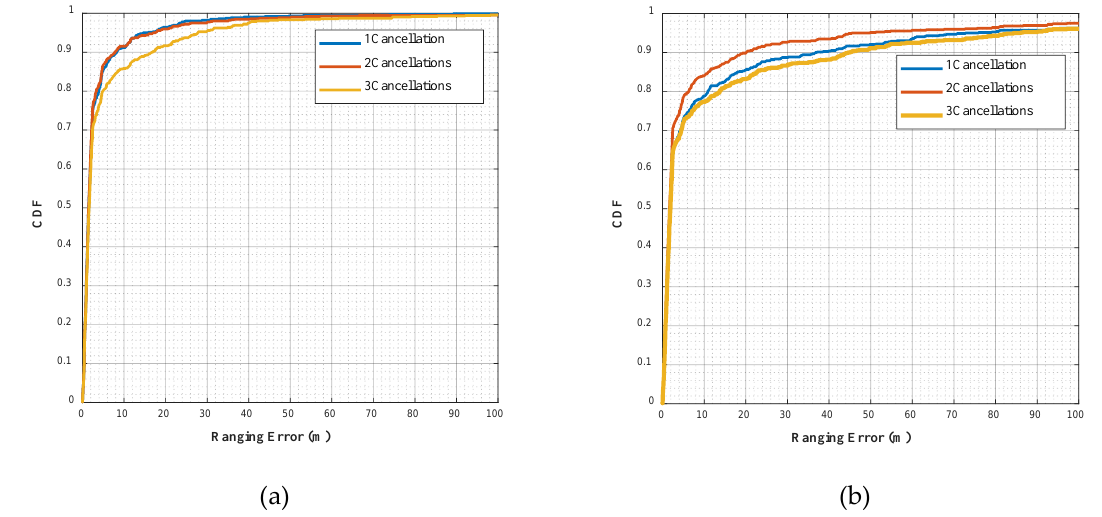
Figure 8. ( a ) CDF of the NC-MUSIC ranging error in UMi scenario with the cancellation time in the set {1,2,3}. ( b ) CDF of the NC-MUSIC ranging error in UMa scenario with the cancellation time in the set {1,2,3}. Table 5. Direct path identification rate of NC-MUSIC in UMi scenario.